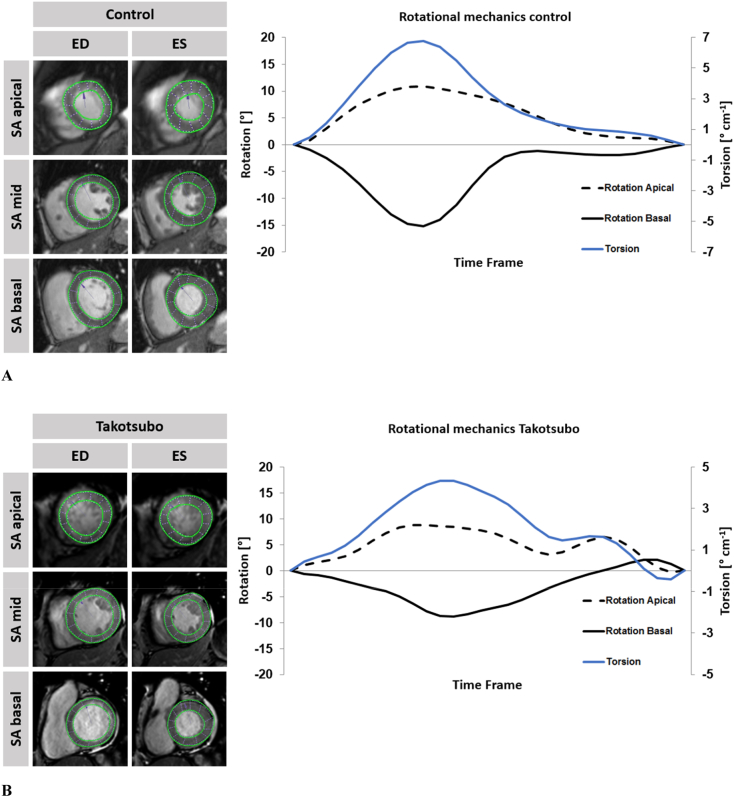
A Apical, midventricular and basal short axis (SA) views of the left ventricle in a representative patient with normal biventricular function.On the left, enddiastolicly (ED) and endsystolicly (ES) tracked endo- and epicardial borders are being displayed in apical, midventricular and basal short axis views of a representative patient with normal biventricular function. On the right respective rotation and torsion is being plotted over a single cardiac cycle.B Apical, midventricular and basal short axis (SA) views of the left ventricle in a representative TTS patient with apical ballooning.On the left, enddiastolicly (ED) and endsystolicly (ES) tracked endo- and epicardial borders are being displayed in apical, midventricular and basal short axis views of a representative patient with apical ballooning Takotsubo syndrome. On the right respective rotation and torsion is being plotted over a single cardiac cycle.